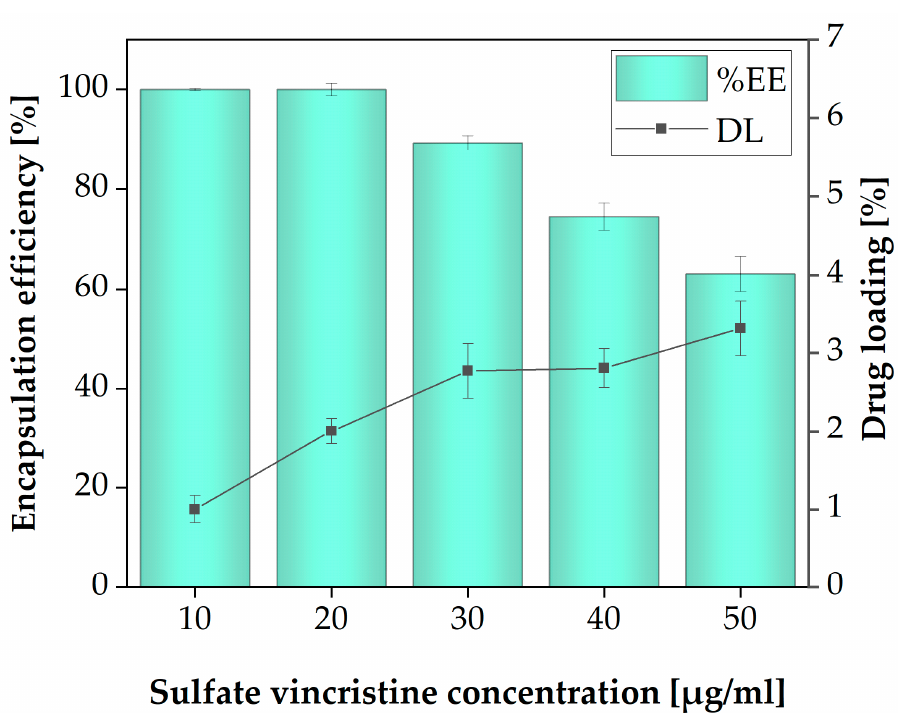
Figure 7. Sulfate vincristine loading and encapsulation efficiency of sample Np 3.